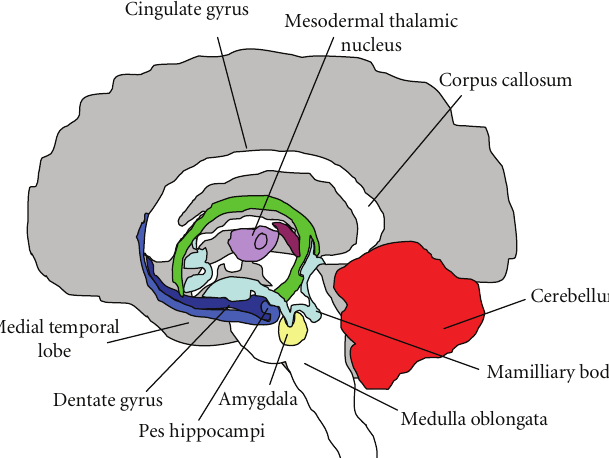
Figure 2: The hippocampus is a part of the forebrain, located in the medial temporal lobe. The hippocampus is used in storing and processing spatial information. In the rabbit model of pneumococcal meningitis, hippocampal apoptosis was found to be the predominant form of neuronal damage. In humans, apoptosis and pyknosis have been identified in the dentate gyrus of the hippocampus. Apoptosis primarily a ff ects the subgranular zone containing recently divided immature neurons. Pyknosis occurs throughout the dentate granular cell